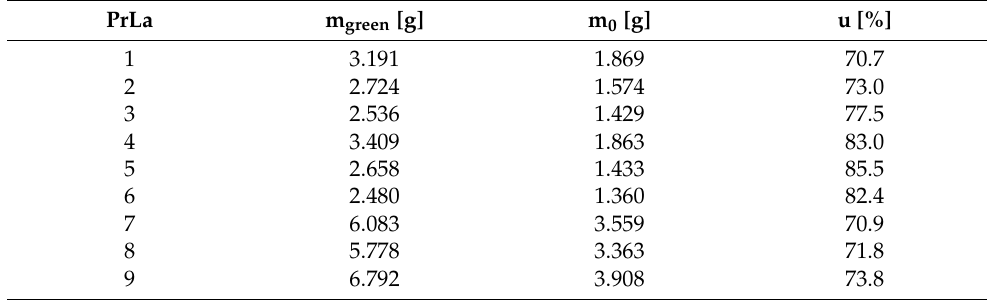
Table A1. Gravimetrically determined moisture content (MC) of nine intact samples of cherry laurel ( Prunus laurocerasus